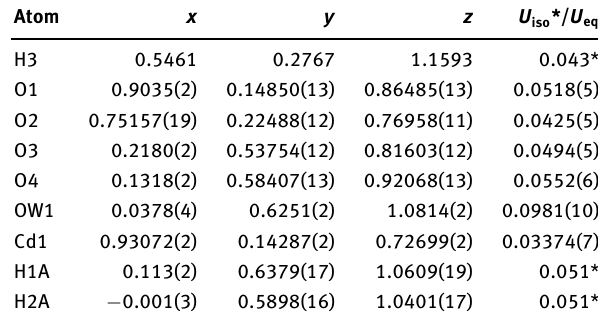
Table 2: Fractional atomic coordinates and isotropic or equivalent isotropic displacement parameters (Å 2